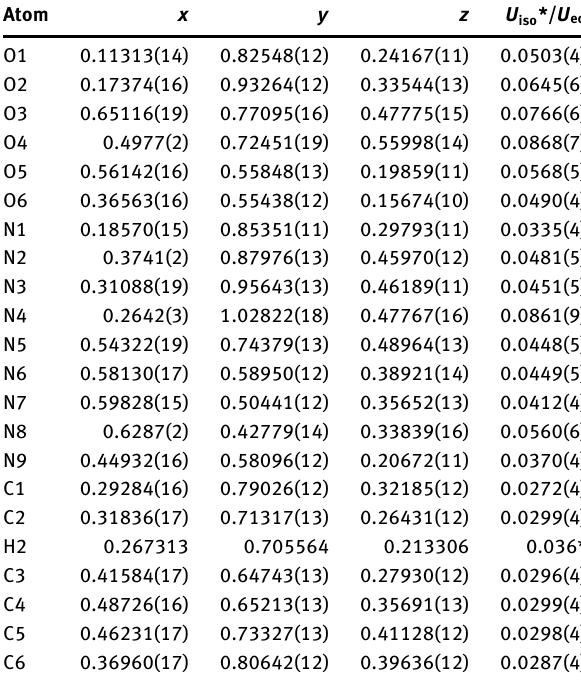
Table 2: Fractional atomic coordinates and isotropic or equivalent isotropic displacement parameters (Å 2